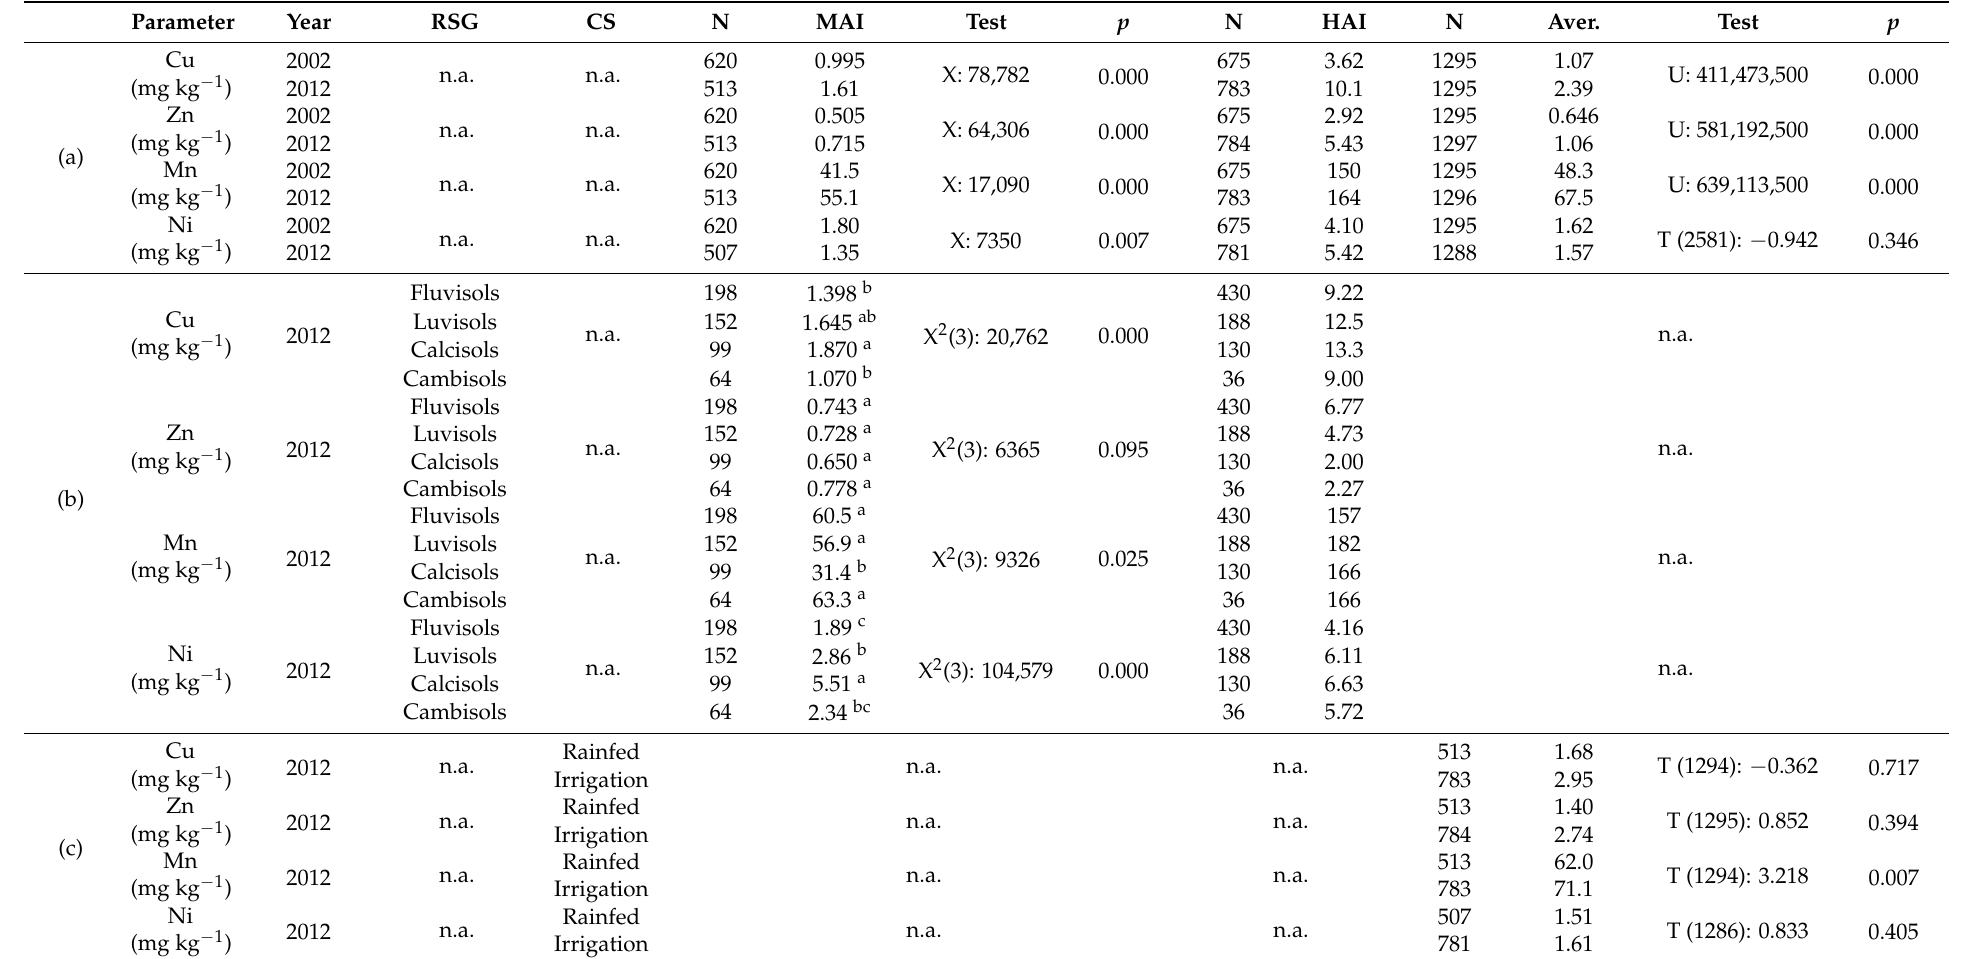
Table 2. Available Cu, Zn, Mn, and Ni concentrations ( a ) in 2002 and 2012 for MAI, HAI, and average; ( b ) MAI and HAI by RSG in 2012; ( c ) average by cultivation system in 2012; and ( d ) average by cultivation system and RSG in